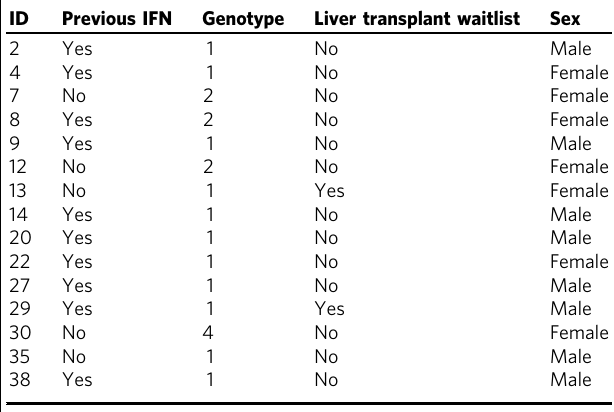
Table 1 HCV patient characteristics